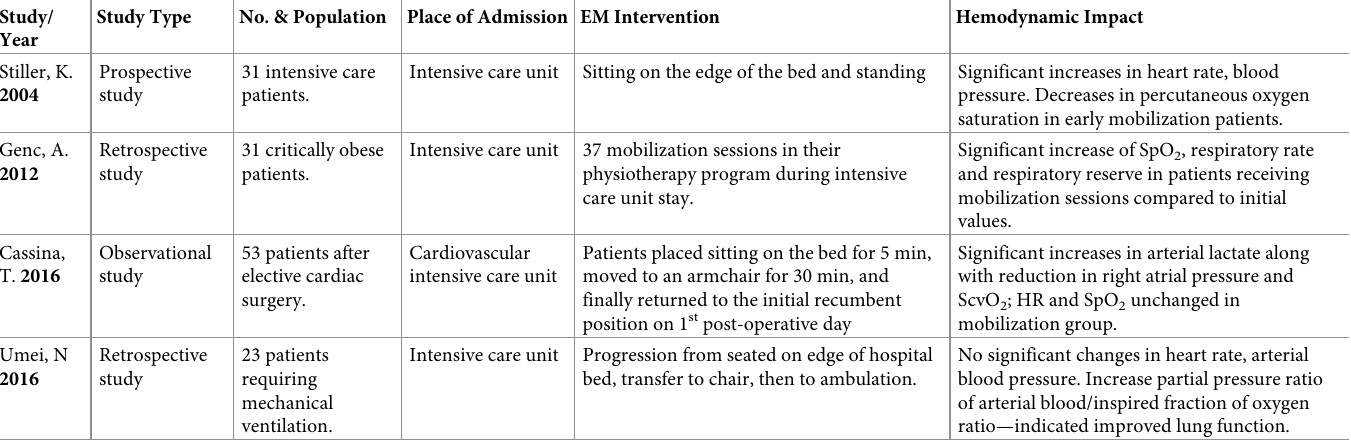
Table 2. Hemodynamic impact of early-mobilization